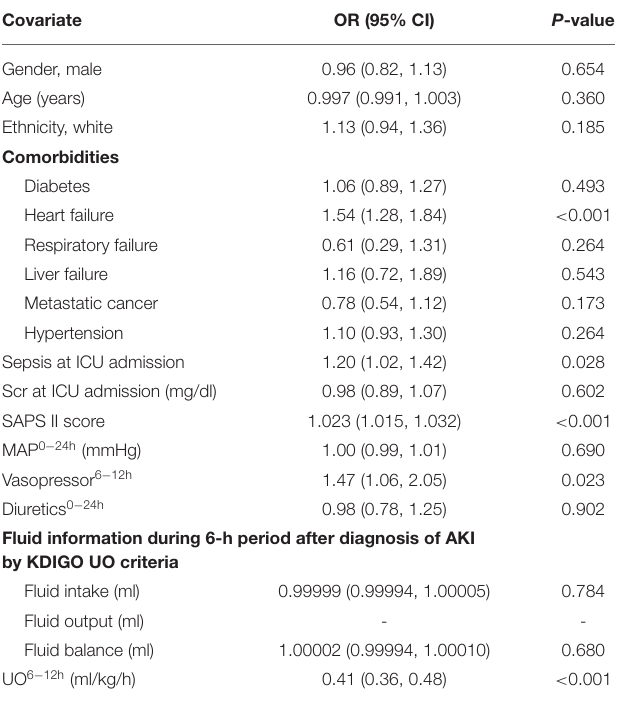
TABLE 2 | Multivariate analysis for progression to stage 2/3 AKI by UO.